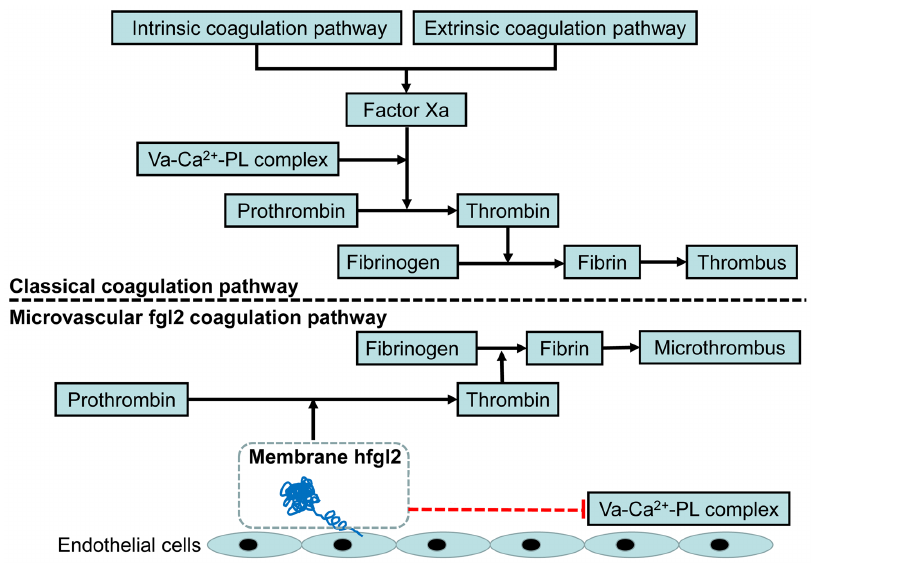
Figure 8. A possible mechanism underlying the fgl2 coagulation pathway and the inhibition of fgl2 prothrombinase activity. Based on our observations and the results from other groups, the possible mechanism underlying the fgl2 coagulation pathway and inhibition of NPG-12 are summarized. Va: factor Va, PL: phospholipids, ECs: endothelial cells.